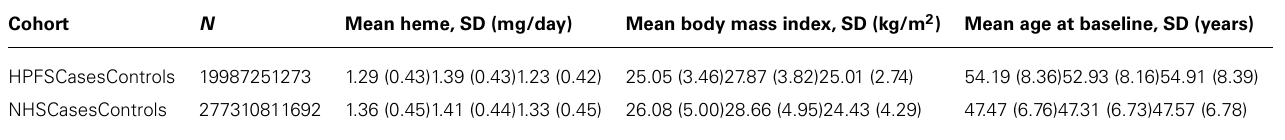
Table 1 | Characteristics of Health Professionals Follow-up Study (HPFS) and Nurses’ Health Study (NHS) cohorts. Cohort N Mean heme, SD (mg/day) Mean body mass index, SD (kg/m 2 ) Mean age at baseline, SD (years) HPFSCasesControls